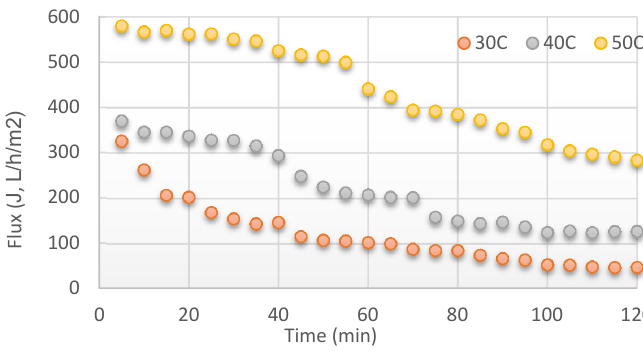
Figure 13. Effect of temperature on permeate flux of pineapple juice (TMP = 2 bars; membrane = 500 nm).